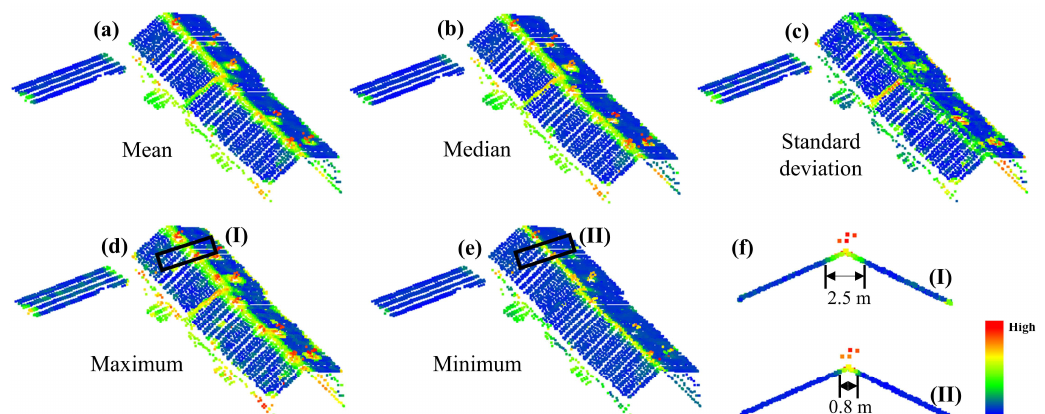
Figure 2. Different statistical measures computed for omnivariance: (a) mean, (b) median, (c) standard deviation, (d) maximum and (e) minimum. In (f) the profiles for regions I and II are